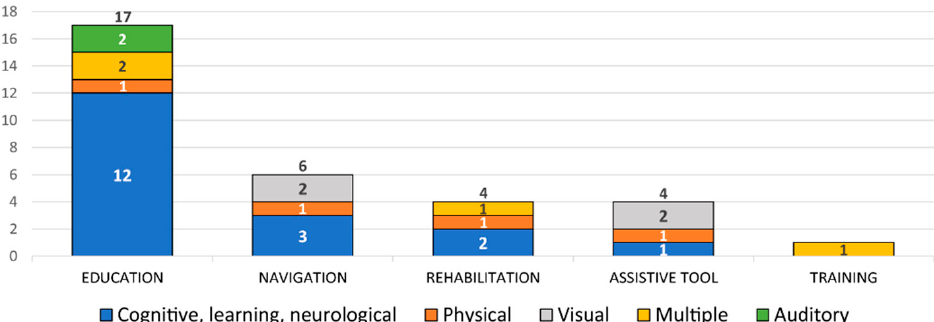
Figure 4. Distribution of AR solutions by disability and application-domain categories.